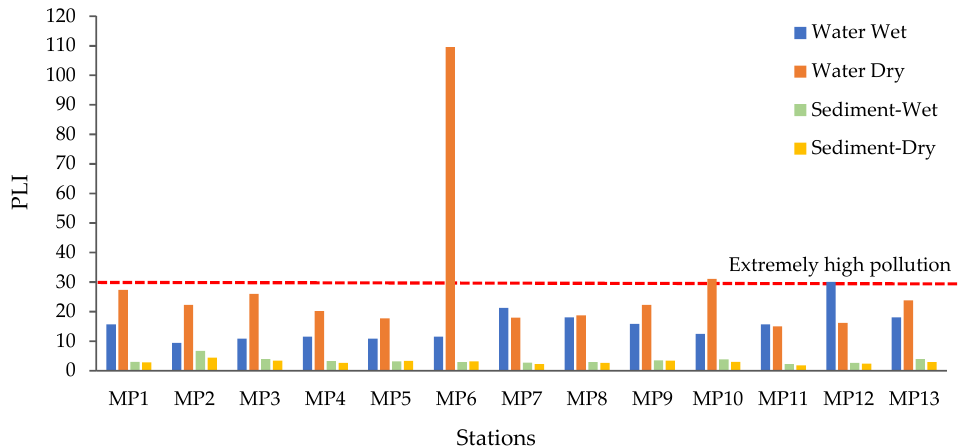
Figure 6. Microplastic pollution load index of surface water and sediment during wet and dry sea- sons.